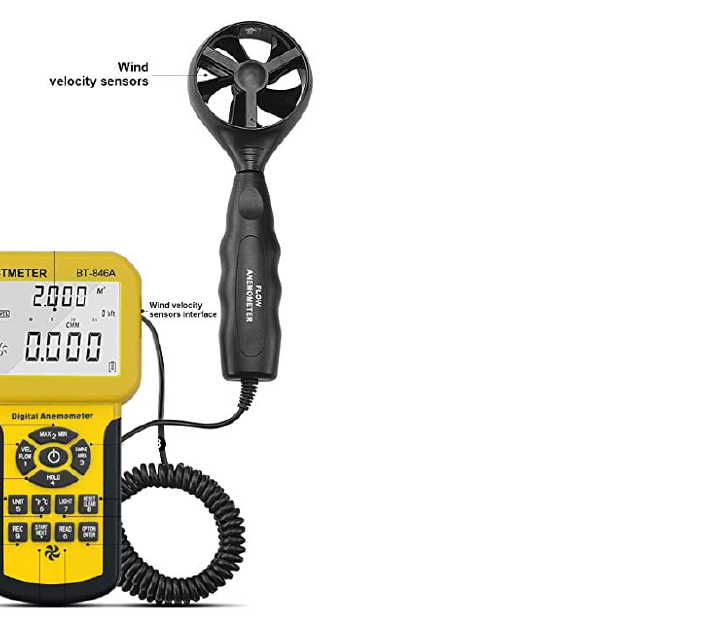
Figure 6. Anemometer: temperature and wind speed sensor.